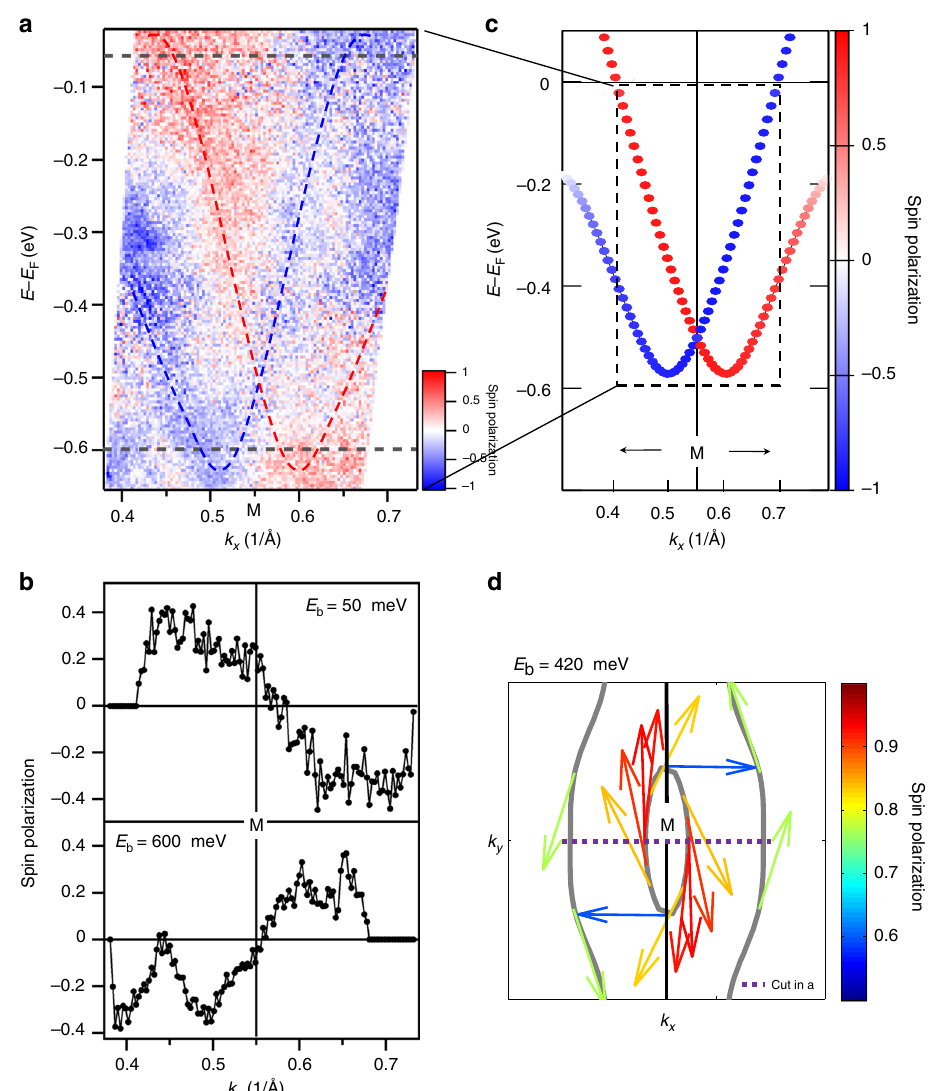
Fig. 3 Spin texture of the Rashba-like splitting. a Spin-resolved band image around the M point along Γ – M – Γ ( k x ) measured by spin-resolved and angle- resolved photoemission spectroscopy (SARPES) ( h ν = 8.4 eV). The red and blue lines indicate the locations of the Rashba-split bands, while the horizontal gray dashed lines indicate the energy positions of the momentum distribution curves (MDCs) in b . b MDCs of spin polarization at E b = 50 and 600 meV extracted from the data in a . c Calculated spin polarization of the Rashba-split bands ( k y = k z = 0). d Spin texture on the constant-energy contours around M point at E = 420 meV. Arrows indicate the spin direction while their color indicates the degree of spin polarization. It has been checked that the b experimental data in b exhibits the same spin chirality as the calculated data in d . The scale bars in a , c , and d represent spin apparent that the left(right) band dispersion is dominated by demonstrated in Fig. 3b, which shows the momentum distribu- tion curves (MDCs) of spin polarization at binding energies of 50 and 600 meV. The calculated spin-resolved band structure is displayed in Fig. 3c, which shows good agreement between the theoretical calculation and experimental data. Figure 3d shows the calculated spin texture on the constant-energy contour at E b = 420 meV, where the arrows show the in-plane orientation of spin and their color indicates the degree of spin polarization. Both the inner ellipse and outer open contours around M exhibit a helical spin structure. The spin polarization in experiments is by a factor of 2 – 3 lower than in the calculations. This was usually observed and might be related to the k -space resolution in experiments, in fl uence of the inelastic background, and sample inhomogeneity.